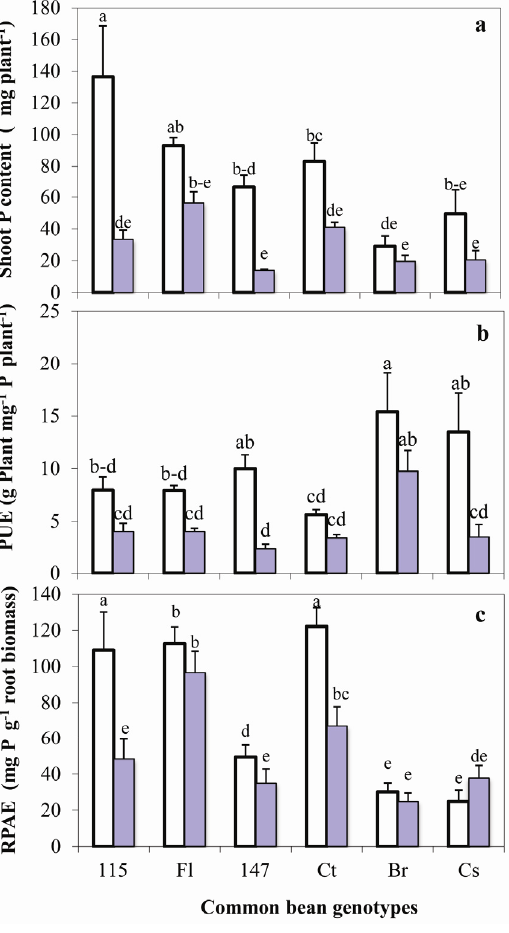
Figure 5. Shoot P content ( a ); P use efficiency (PUE) ( b ) and P absorption efficiency by root (RPAE) ( c ) of six common bean genotypes grown under sufficient P (empty bar) versus low P (filled bar) soil. Data are means ± se of six replicates harvested at flowering